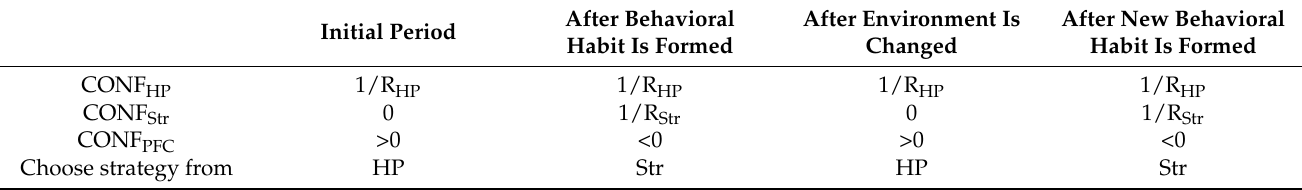
Table 1. A qualitative analysis of “confidence” in the prefrontal cortex during different periods. After Behavioral Initial Period Habit Is